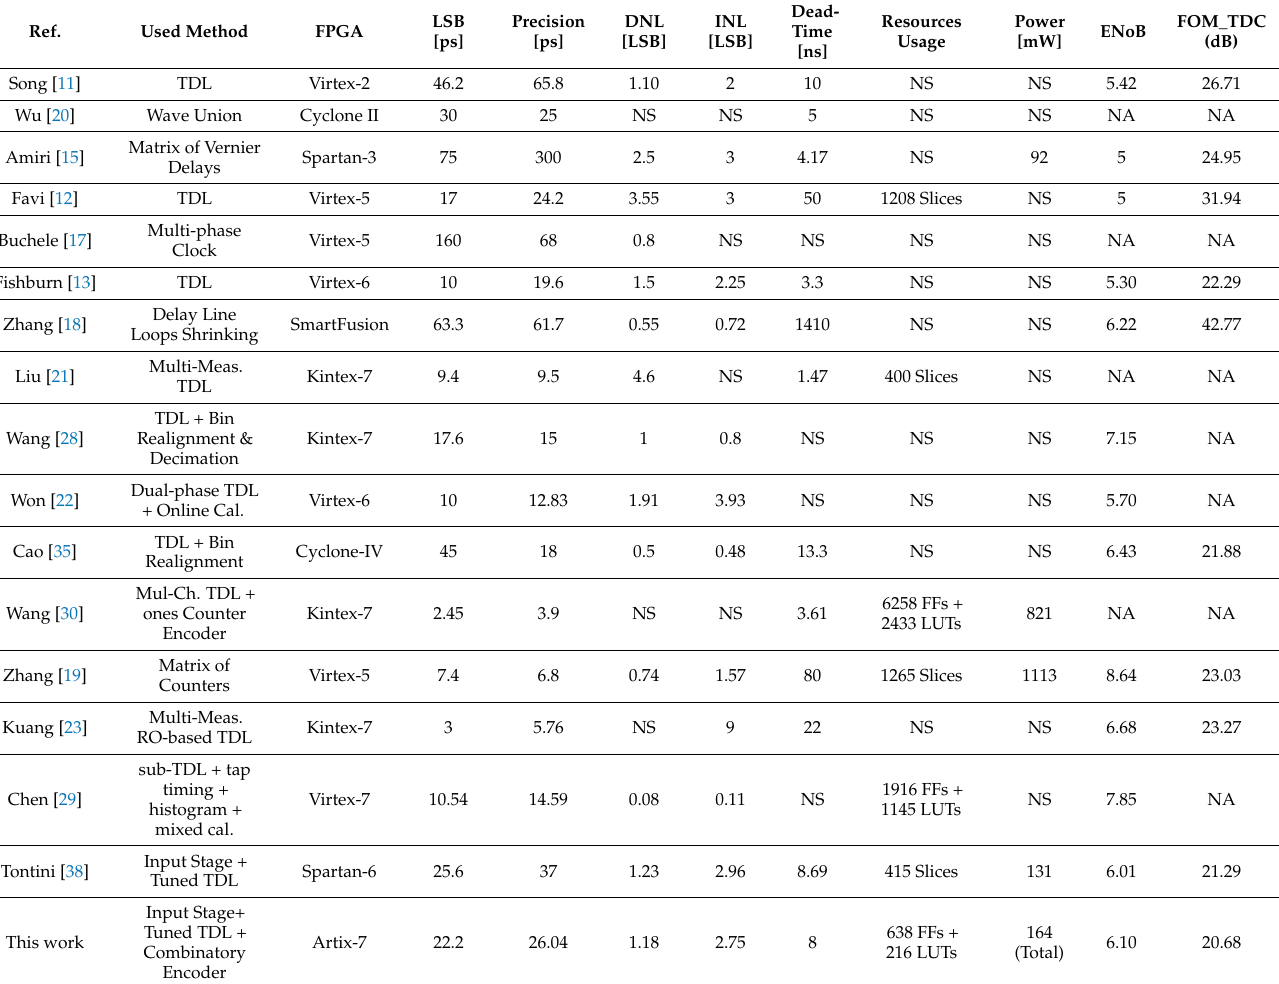
Table 5. Comparison with the state-of-the-art FPGA-based